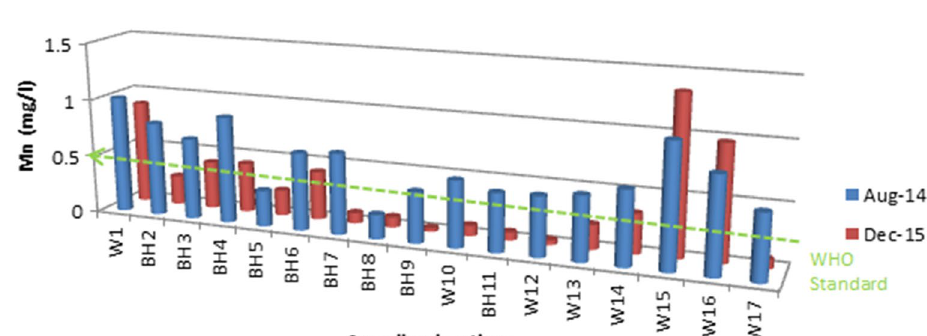
Fig. 15 Seasonal variations in Mn concentration of water sample versus WHO standard around the Olusosun